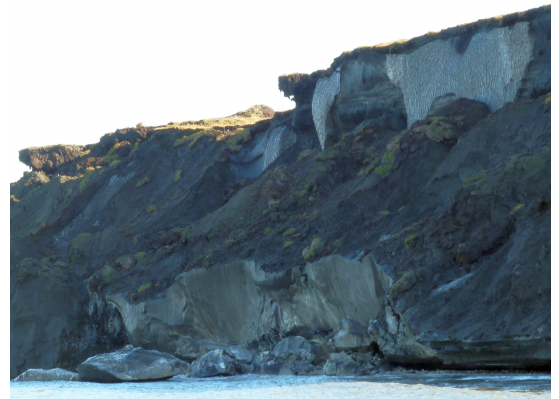
Figure 23. Photograph of catastrophic collapse through undercut- ting, reflecting activation of TA during the rising water level at the end of August 2011, when sea water comes in contact with per- mafrost at the level of thermo-niches. Under calm weather condi- tions the ground ice block decayed within 2